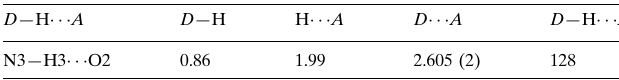
structure: SHELXL97 (Sheldrick, 2008); molecular graphics: SHELXTL (Sheldrick, 2008); software used to prepare material for publication: SHELXTL